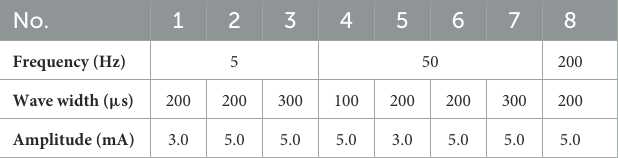
TABLE 3 Selected parameters tested in the long-term experiments.